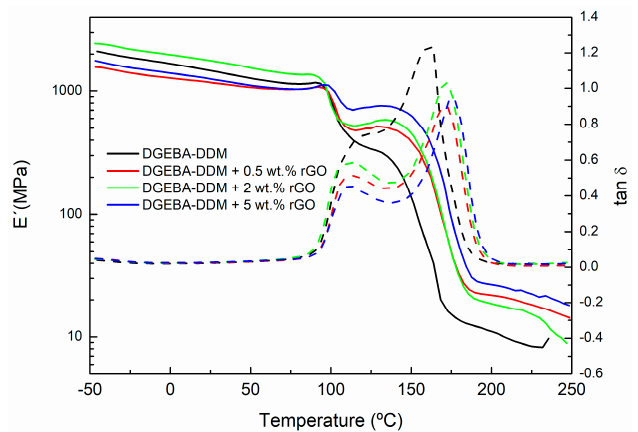
Figure 12. Storage modulus and tan δ of neat epoxy and composites with 0.5, 2 and 5 wt % of rGO cured at a temperature of 90 °C.